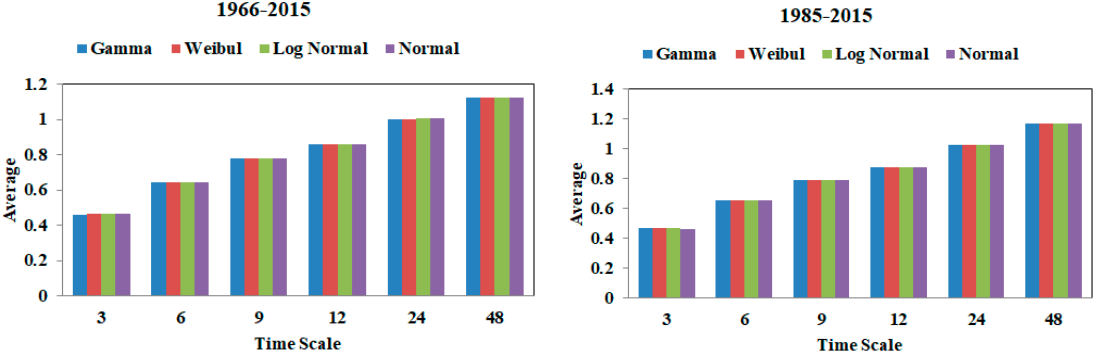
Figure 7. Uncertainty to upper and lower limit for average statistics in various distributions, time scales (3–48 months), and record lengths (49 and 30 years).